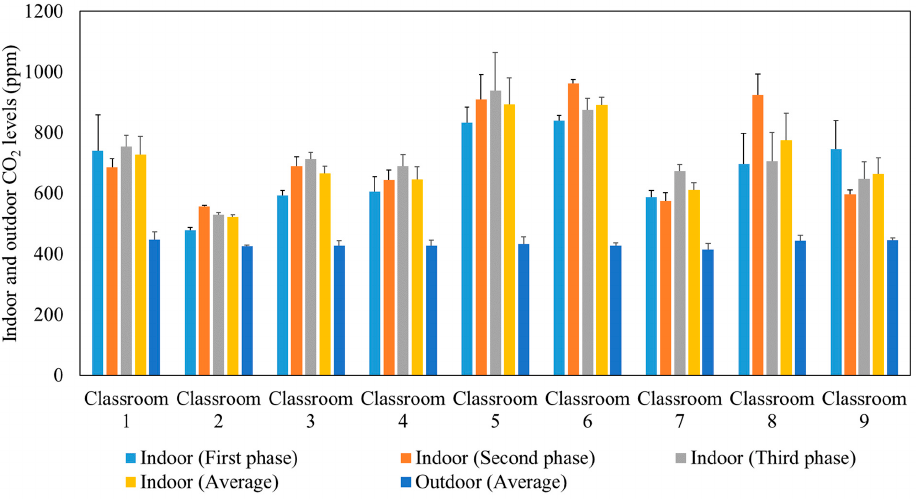
Figure 3. Average outdoor and indoor CO 2 levels during the three phases in the studied classrooms. The error bars indicate standard deviations of values measured in a single day. The error bars indicate standard deviations of values measured in a single